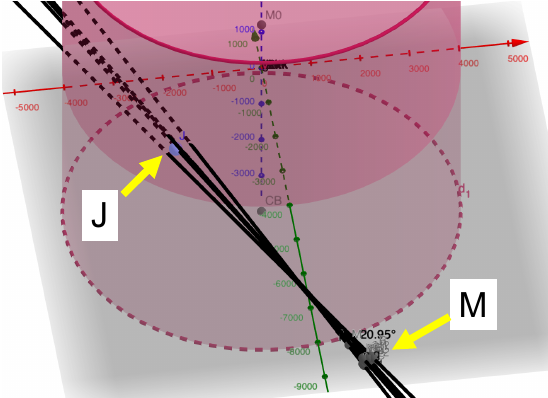
Fig. 2 . Beams propagated from their virtual waist location along their k vectors, estimated path length from waists area to the central column (7.3 m), identified point ”J” at 6.6 m from “M”